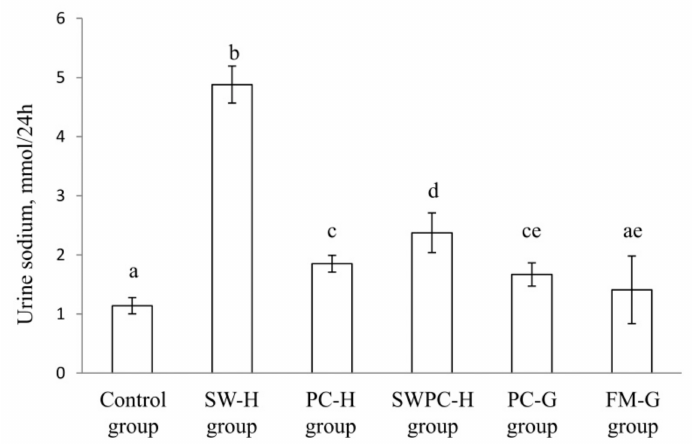
Figure 4. Urine 24 h sodium excretion. Values are means, with standard error of mean represented as vertical bars. Values are shown for n = 8 in Control group, n = 5 in SW-H, and n = 6 in all other groups. Groups are compared using one-way ANOVA with LSD post hoc test when appropriate. Bars with different letters are significantly different ( p < 0.05). SW-H; stickwater from Havstrand, PC-H; presscake meal from Havstrand, SWPC-H; stickwater + presscake meal from Havstrand, PC-G; presscake meal from Granit, FM-G; fillet meal from